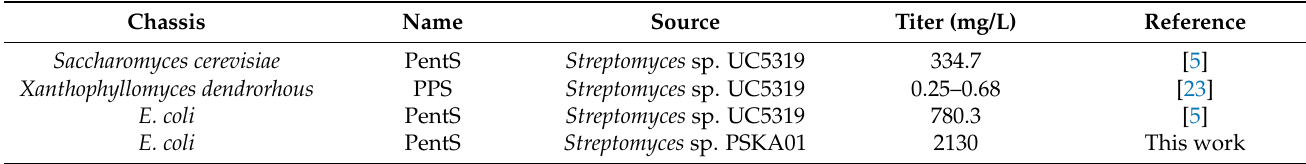
Figure 1. Product spectrum and pentalenene production of wild type and mutants of PentS. ( A ) Comparison of gas chromatogram between wild type and mutants. Peaks a and b indicate unidentified hydrocarbons with m / z 204. 1 – 6 were tentatively predicted as pentalenene, sativene, longifolene-V4, β -chamigrene, thujopsene-I3, and β -elemene, respectively. IS, the internal standard β -caryophyllene. ( B ) Chemical structures of sesquiterpenes detected. ( C ) Three-dimensional structure of wild-type PentS and location of the four mutation sites of PentS-13. ( D ) Pentalenene production of wild-type PentS and the four single-site mutants. Table 2. Comparison of pentalenene production in the engineered strains.